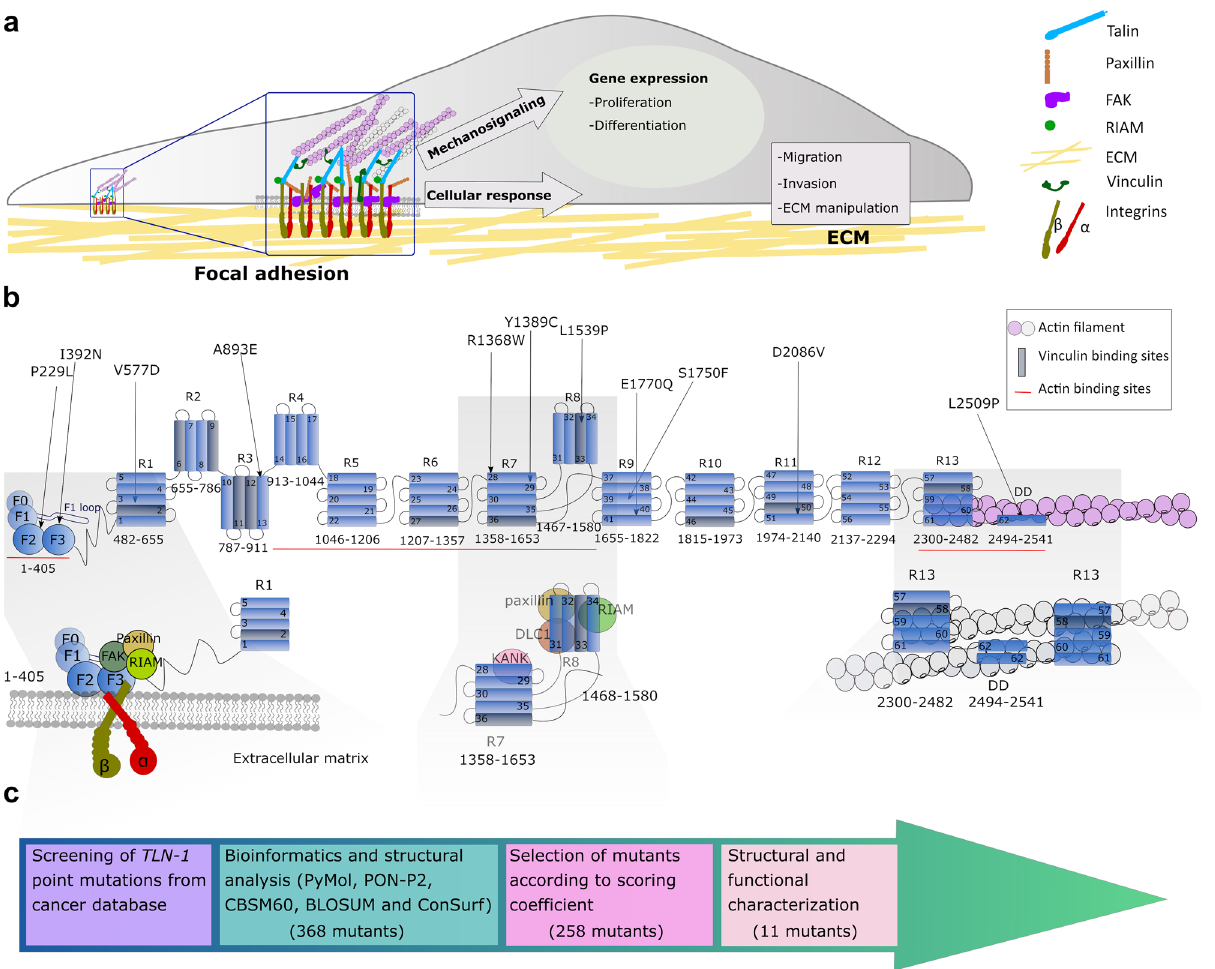
Figure 1. Analysis of talin-1 mutations found in the COSMIC database. ( a ) Schematic representation of focal adhesion role on cell function. ( b ) Schematic representation of talin-1 and the positions of the selected missense mutations. Bottom: cartoon of the talin head complexes that form with integrin, FAK, paxillin and RIAM (left), talin R7–R8 complexes with KANK, DLC-1, RIAM and paxillin (middle) and the R13–DD actin cytoskeletal linkage (right). ( c ) Flowchart showing the study pipeline to investigate TLN–1 mutations from COSMIC